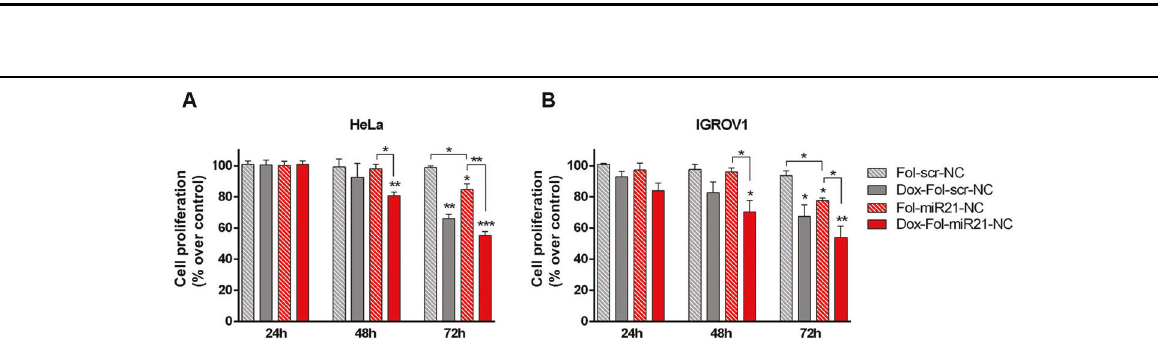
RNA 35 corresponding to 0.12 ng/10 6 cells and that the amount of internalized cages in HeLa is 200 ng/10 6 cells (Fig. 2B), the molar ratio between Fol-miR21-NCs and endogenous miR-21 ranges between 60:1 and 30:1, depending on the experiment. Since each nanocage has four sequestering units, the “ miR-21 sequestering units: endogenous miR-21 ” ratio ranges between 240:1 and 120:1, so there are always more than 100x molar excess of sequestering units. This ratio permits an ef fi cient miR-21 binding, as recently demonstrated in vitro 31 .